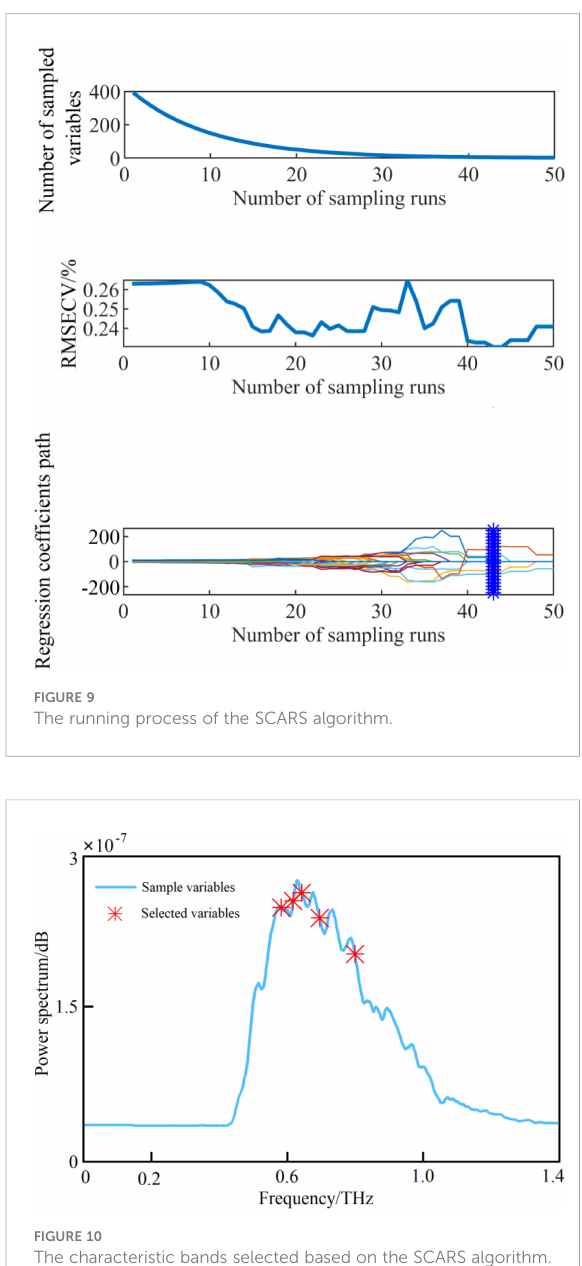
FIGURE 10 The characteristic bands selected based on the SCARS algorithm.